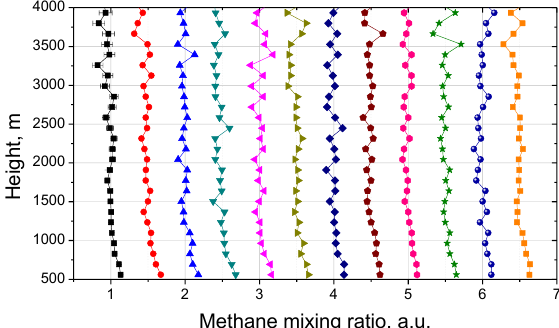
Figure 3. Raman lidar signals on 25-26 December 2018 corresponding to N 2 and CH 4 together with methane mixing ratio obtained with DPSS laser. Averaging time is 7 hours.